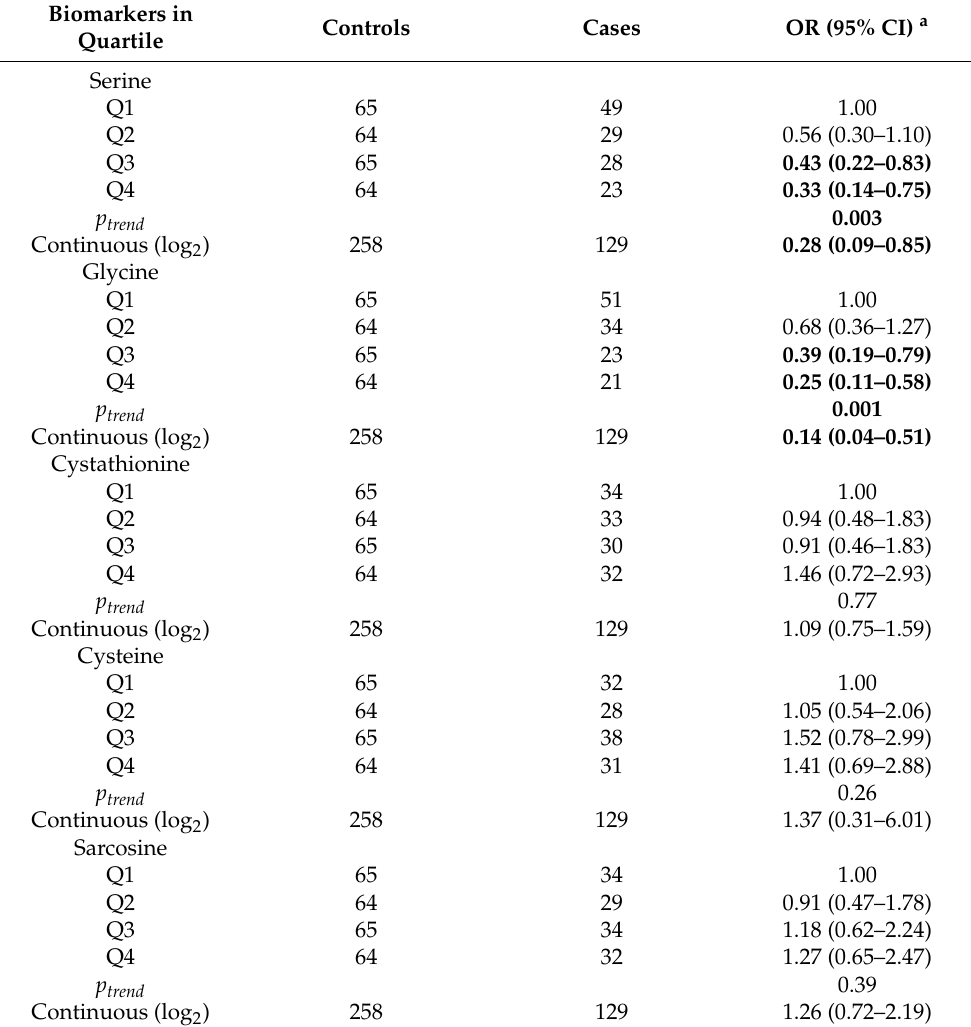
Table 3. Associations between serum concentrations of biomarkers studied and pancreatic cancer risk in the Shanghai Cohort